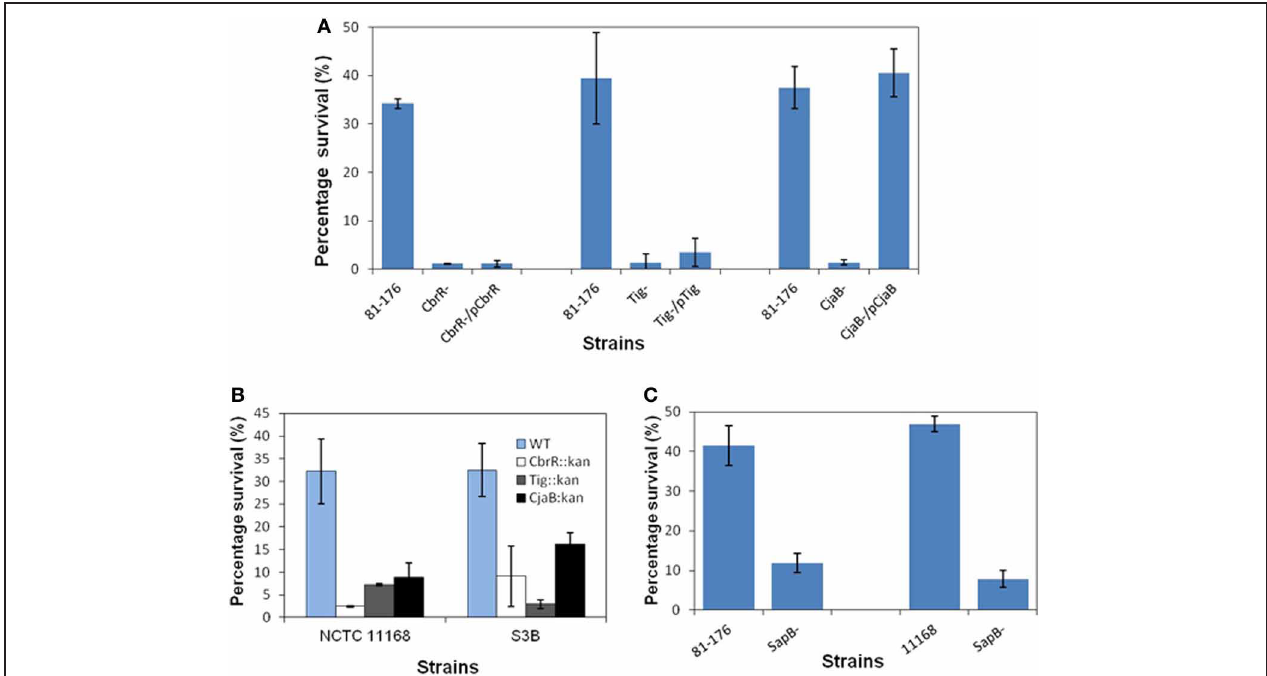
FIGURE 2 | Role of cbrR , tig, cjaB and sapB in F-1 resistance in different C. jejuni strains. (A) Susceptibilities of wild-type 81–176 and its cbrR , tig , and cjaB mutant constructs to F1. (B) Effects of mutations in cbrR , tig, and cjaB on the susceptibilities of C. jejuni NCTC 11168 and S3B to F1. (C) Inactivation of sapB increased susceptibilities of 81–176 and NCTC 11168 to F1. Log-phase cells in MH broth were supplemented with F1 at final concentration of 8 μ g/ml and incubated for 2h at 42 ◦ C under